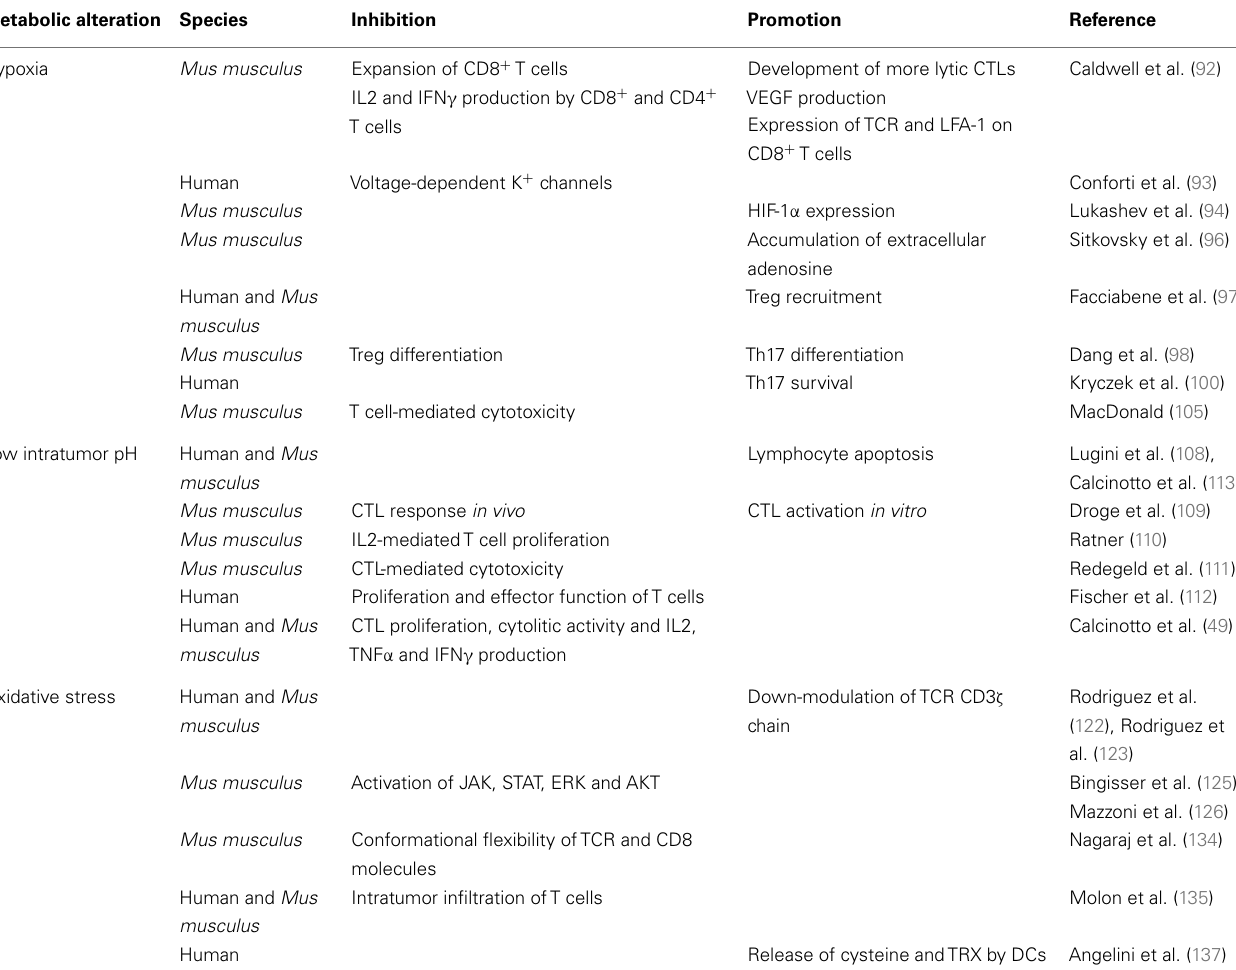
Table 1 | Effects of the tumor metabolism